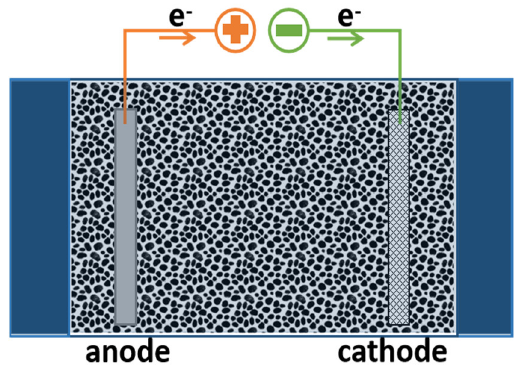
Figure 6. The structure of 3D-ECR.